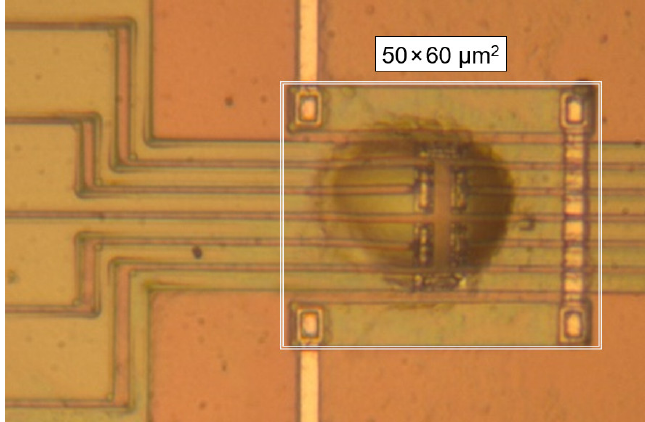
Figure 1. Optical micrograph of the PCL sample on the XI-395 chip-sensor.